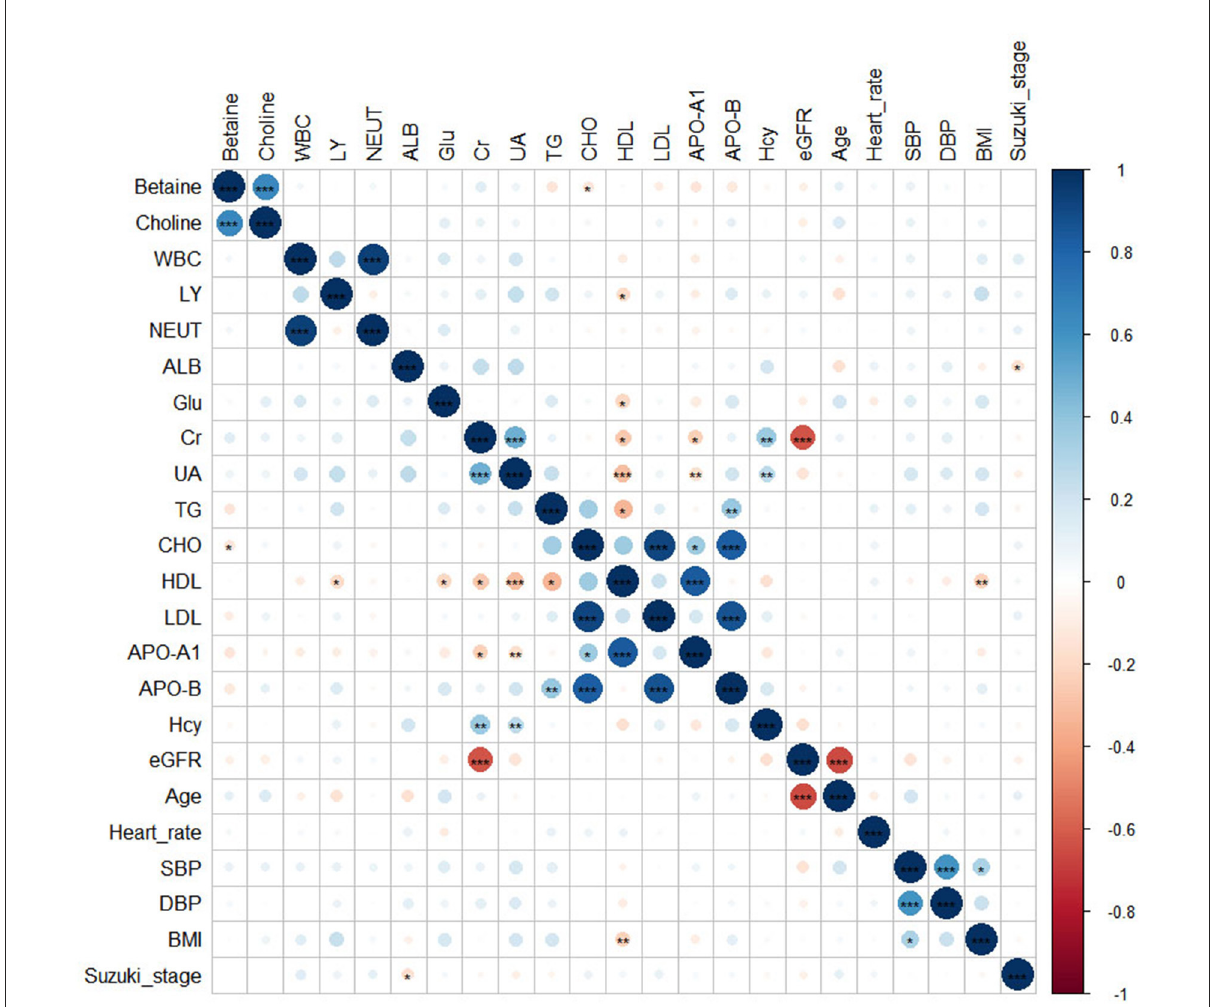
FIGURE2 The heatmap showed the correlations between betaine, choline, and other risk factors. Significance: *** p < 0.001; ** p < 0.01; * p <